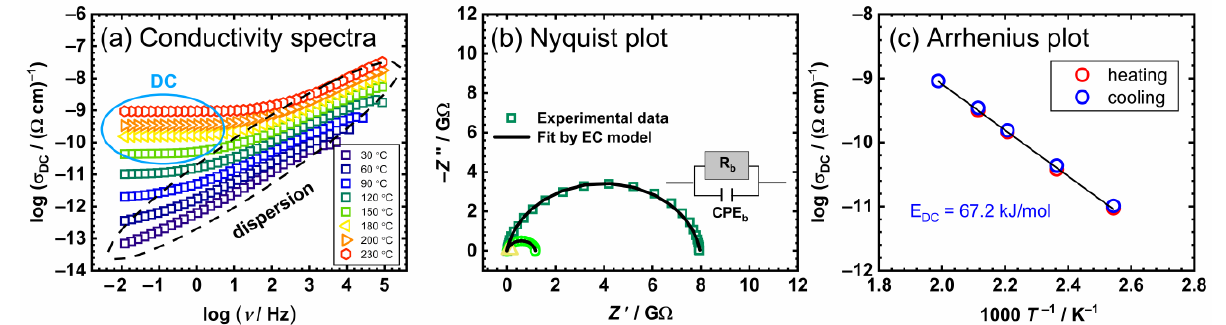
Figure 3. ( a ) Conductivity spectra; ( b ) Nyquist plot; and ( c ) Arrhenius plot—temperature dependence of DC conductivity (log( σ DC ) vs. 1000/T) for compound [MoO 2 (L 1 )] n . In ( c ), the heating run is marked with red circles, and cooling is marked with blue circles.